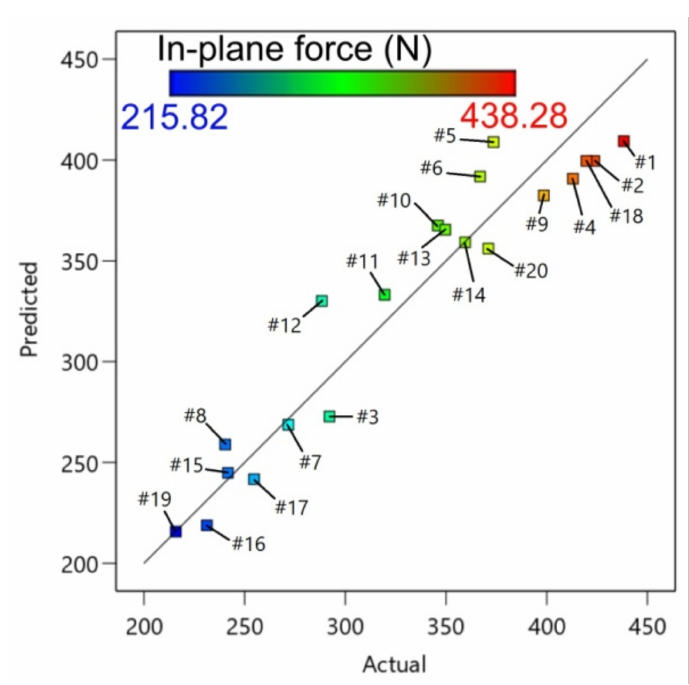
Figure 10. Predicted versus actual response for in-plane